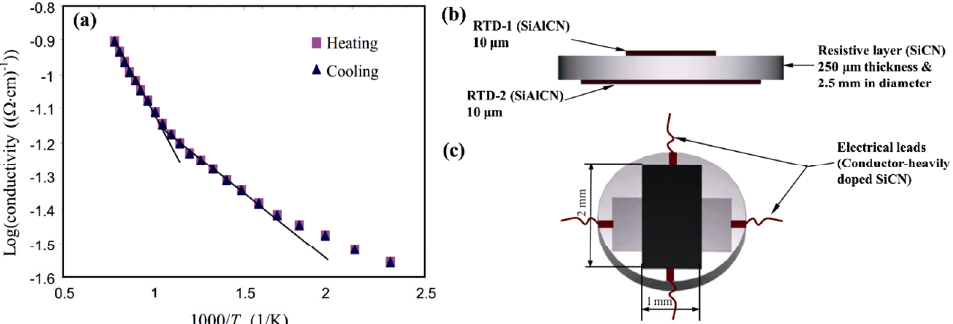
Fig. 14 (a) Electric conductivity of semiconducting SiAlCN as a function of temperature. Schematics of the proposed heat-flux sensor made of PDCs: (b) sectional view and (c) top view. Reproduced with permission from Ref. [364], © IOP Publishing Ltd.